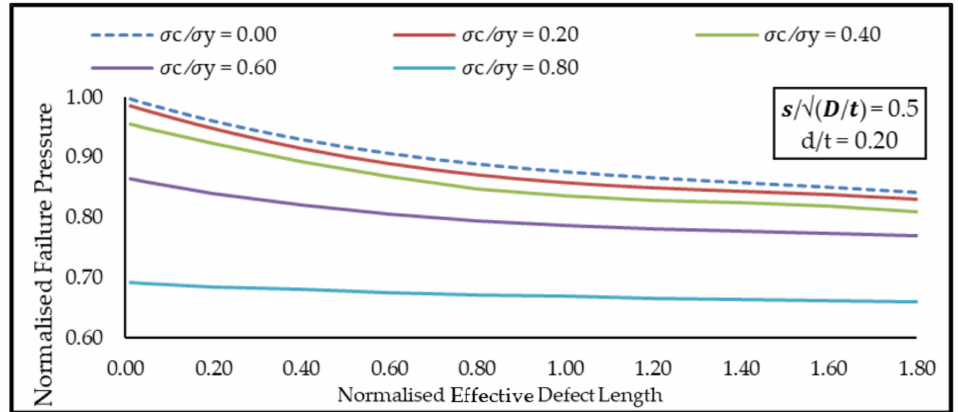
Figure 17. Normalized failure pressure predictions based on the empirical equation against various normalized defect lengths for multiple axial compressive stresses at constant normalized defect spacing of 0.5 and normalized defect depth of 0.20.